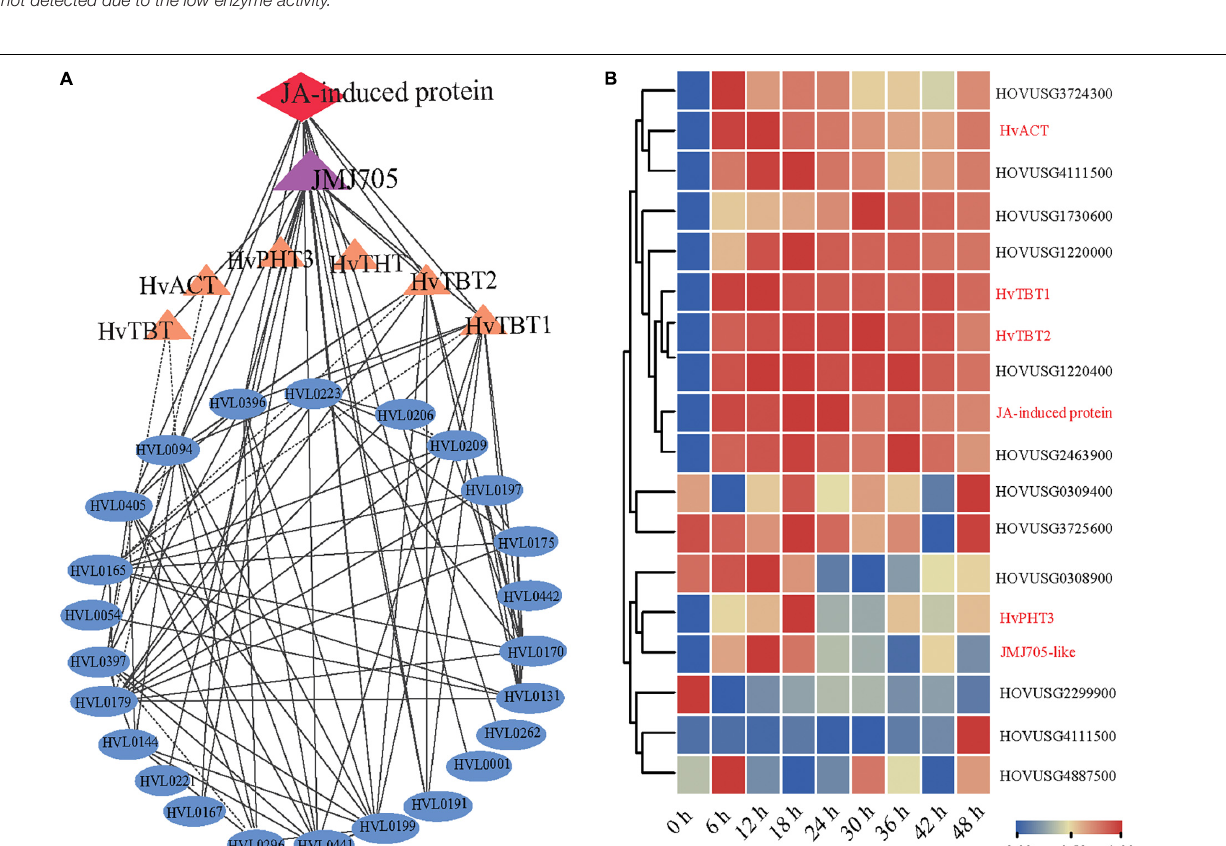
Frontiers in Plant Science |